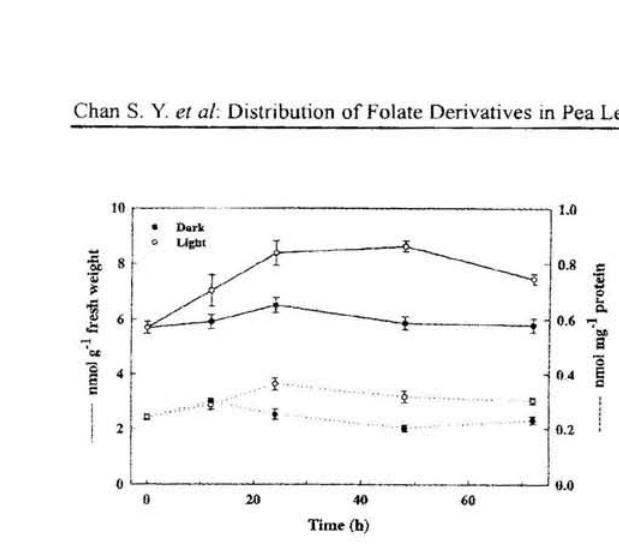
Figure 2 Folate contents of etiolated and greening seedlings. Total folate contents of pea leaves were determined after 9 d etiolated seedlings were kept in the dark or exposed to continuous lightfor 72 h. Data are expressed as means ± SEM, n = 9. biogenesis.